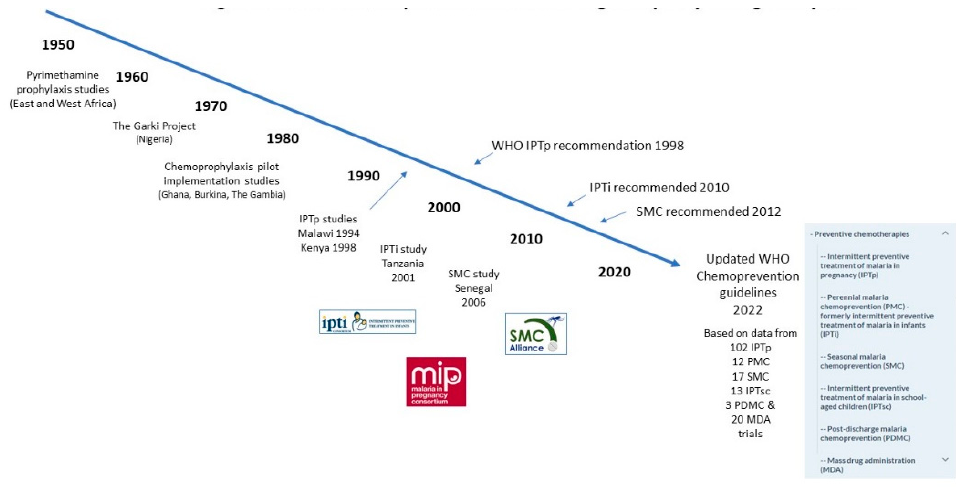
Figure 1. Malaria chemoprevention research & global policy through the